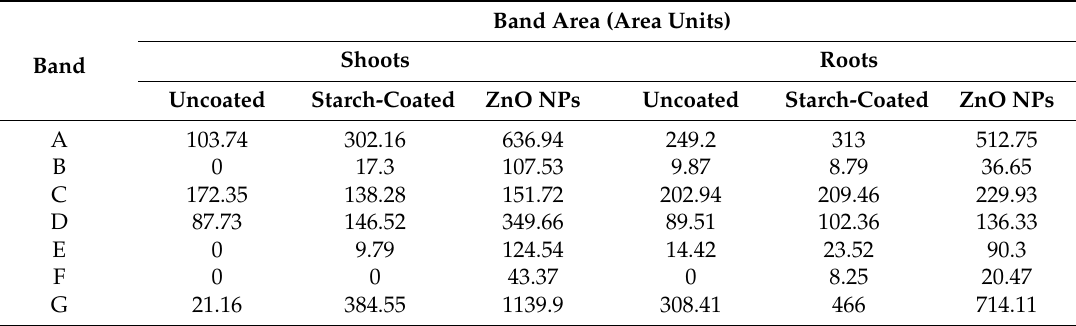
Table 4. FTIR-ATR band areas of maize shoots and roots.